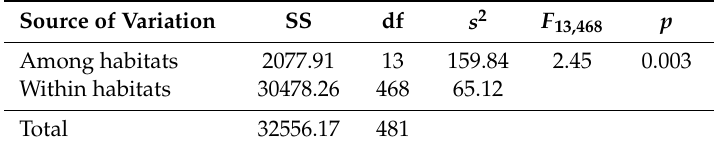
Table 2. Results of one-way analysis of variance on Caulerpa cylindracea cover data in the 14 EUNIS habitats recognized in the marine protected area of